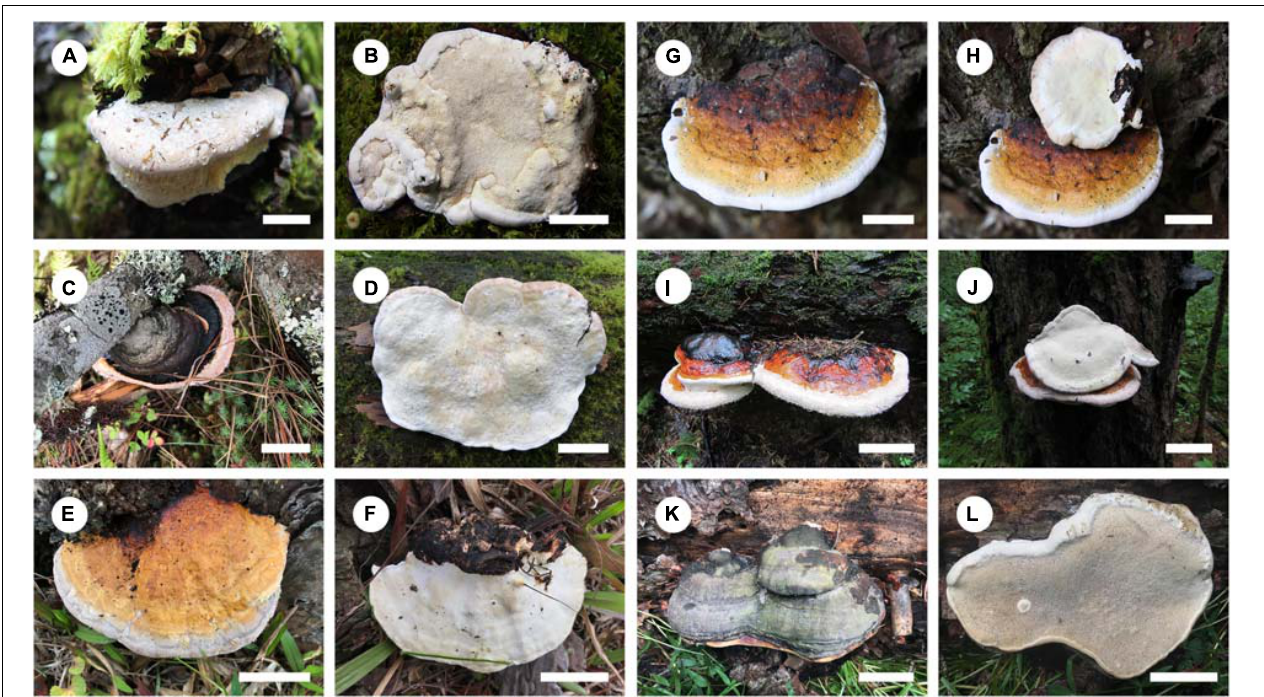
FIGURE 3 | Basidiocarps of the Fomitopsis pinicola complex species. (A,B) F . abieticola ; (C,D) F . hengduanensis ; (E,F) F . kesiyae ; (G,H) F . massoniana ; (I,J) F . subpinicola ; (K,L) F . tianshanensis . Bars: A,B,D,E,F = 2 cm; G,H = 1 cm; C,I,J = 3 cm; K,L = 5 cm.